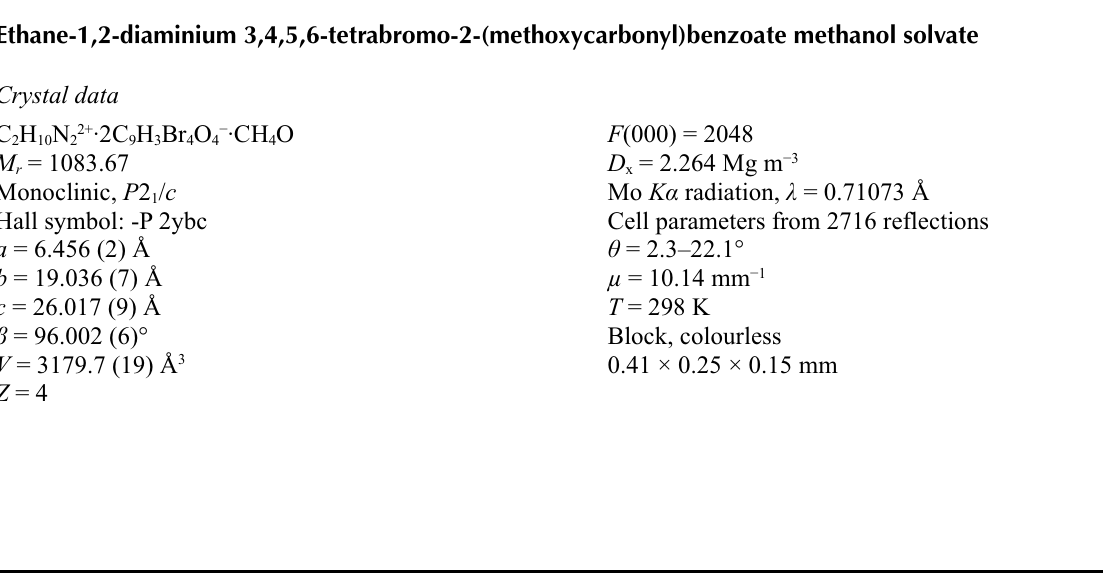
The crystal packing of (I), viewed along a axis. Hydrogen bonds are indicated by dashed lines. [Symmetry code: (i) - x + 2, y - 1/2, - z + 1/2; (ii) - x + 2, - y + 1, - z + 1; (iii) - x + 1, y - 1/2, - z + 1/2; (iv) - x + 1, - y + 1, - z + 1; (v) x - 1, y , z ; (vi) - x + 1, - y + 2, - z +